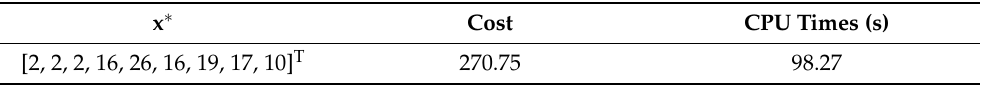
Table 3. The quasi-optimal design x ∗ , cost and the consumed CPU time of the best run in large